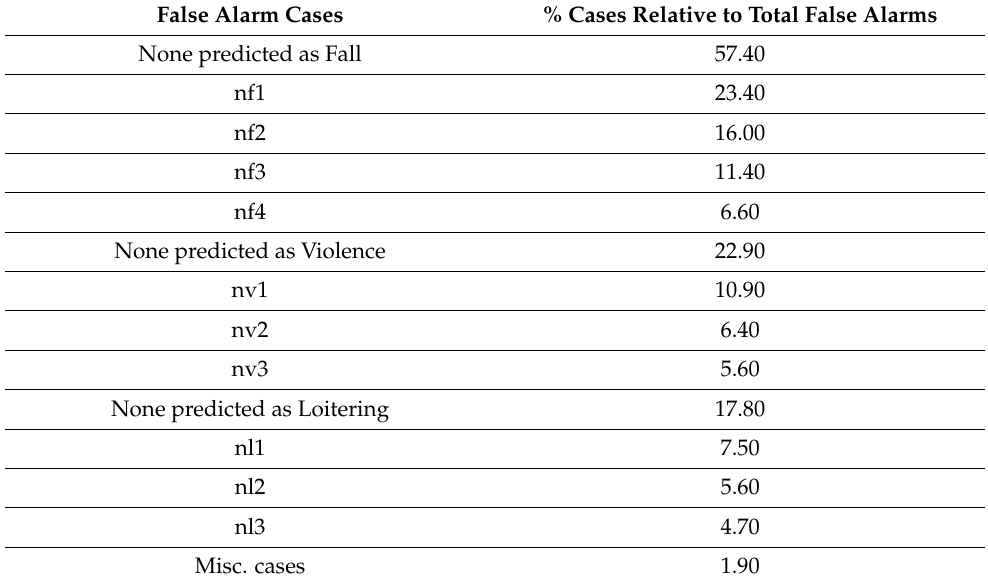
Table 2. Percentage of different cases of false alarms. False Alarm